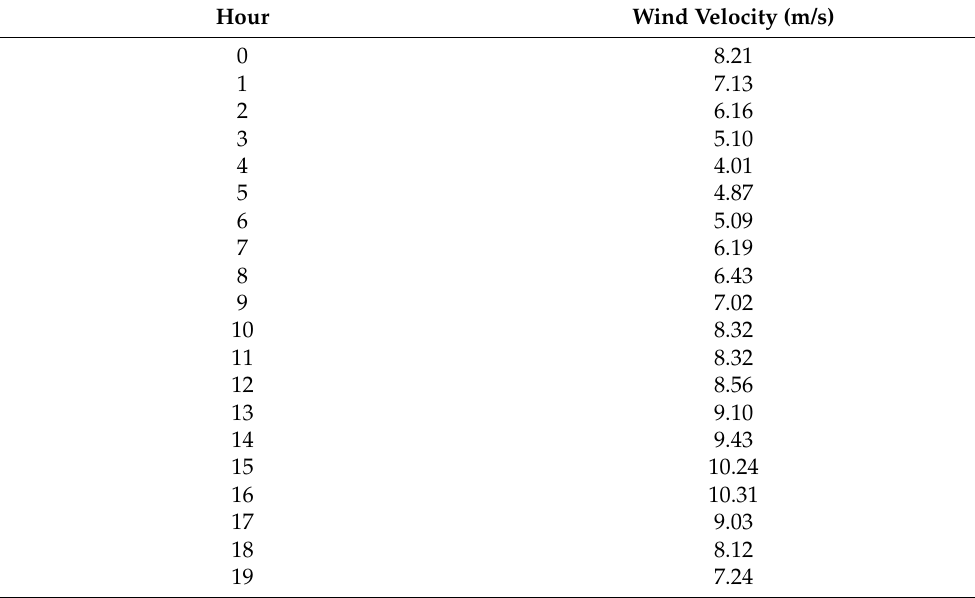
Table 6. Predicted values of the wind